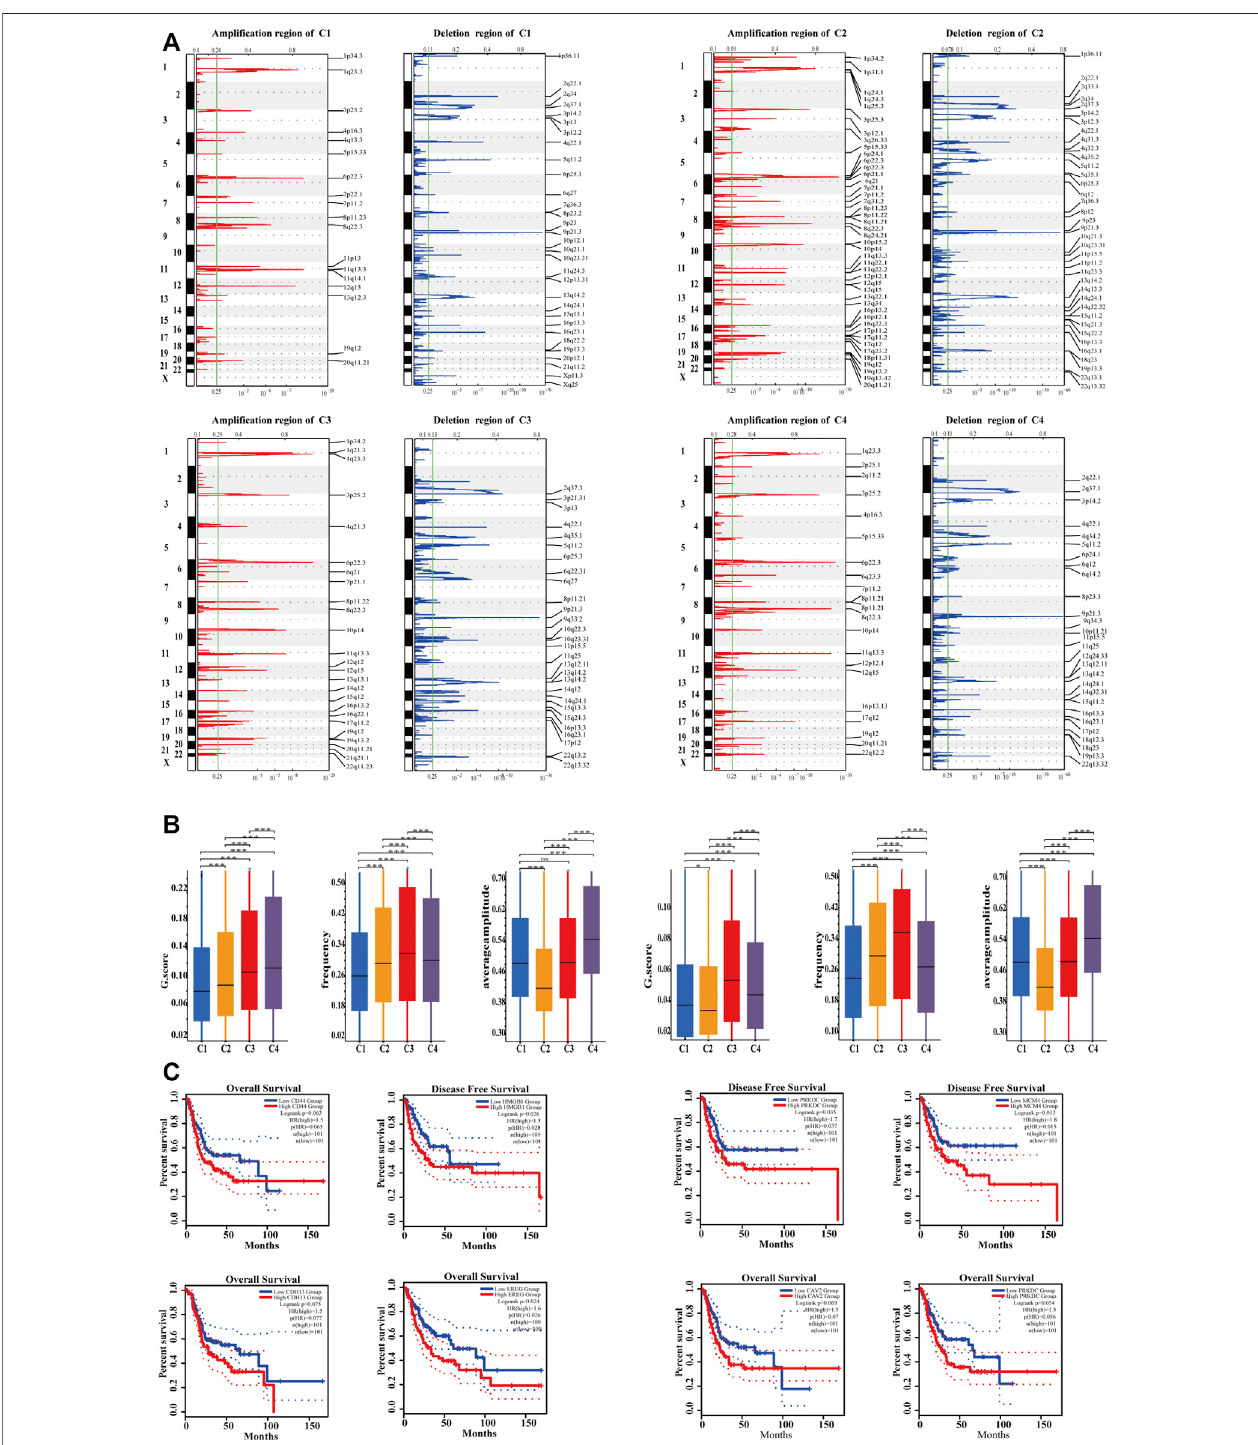
FIGURE 6 | Characterization of genomic driver mechanisms by SCNAs in four subtypes. (A) The four subtypes had signi fi cantly different recurrent SCNA regions. Ordinates represent chromosomal regions. (B) The four subtypes had signi fi cantly different GISTIC score, mutation frequency, and average amplitude (Kruskal – Wallis test, p < .05). C4 had the highest SCNA level; C2 had the lowest SCNA level though it had the highest mutation frequency and the lowest mutation amplitude. (C) In the C2subtype, theexpression ofhighlyampli fi edgenestended tocorrelatewithpoorprognosis.Cutoffvalueofhigh andlowexpression groupswere75%and 25%.